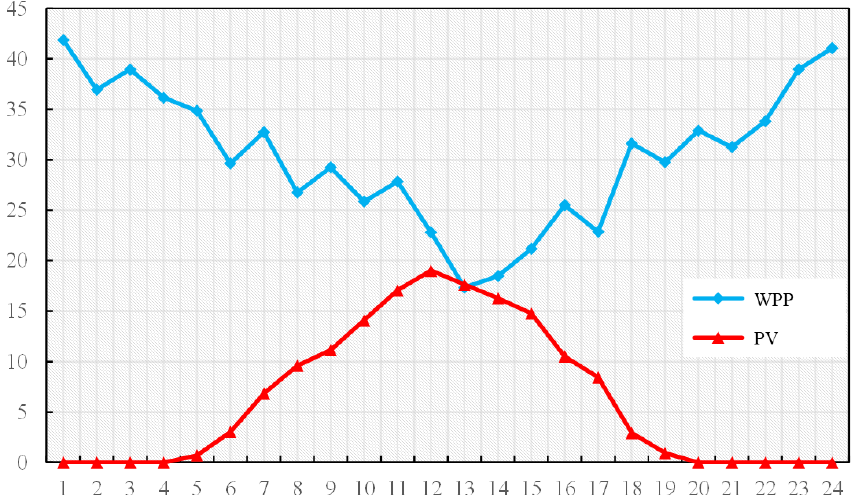
Figure 4. Available output power of wind and solar power (MWh). Table 1. Units’ generation parameters setting.